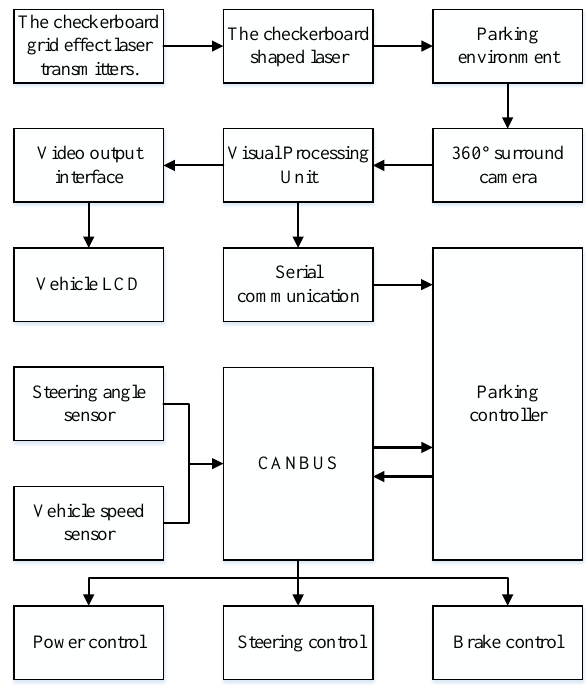
Figure 1. System Figure 1. System construction.